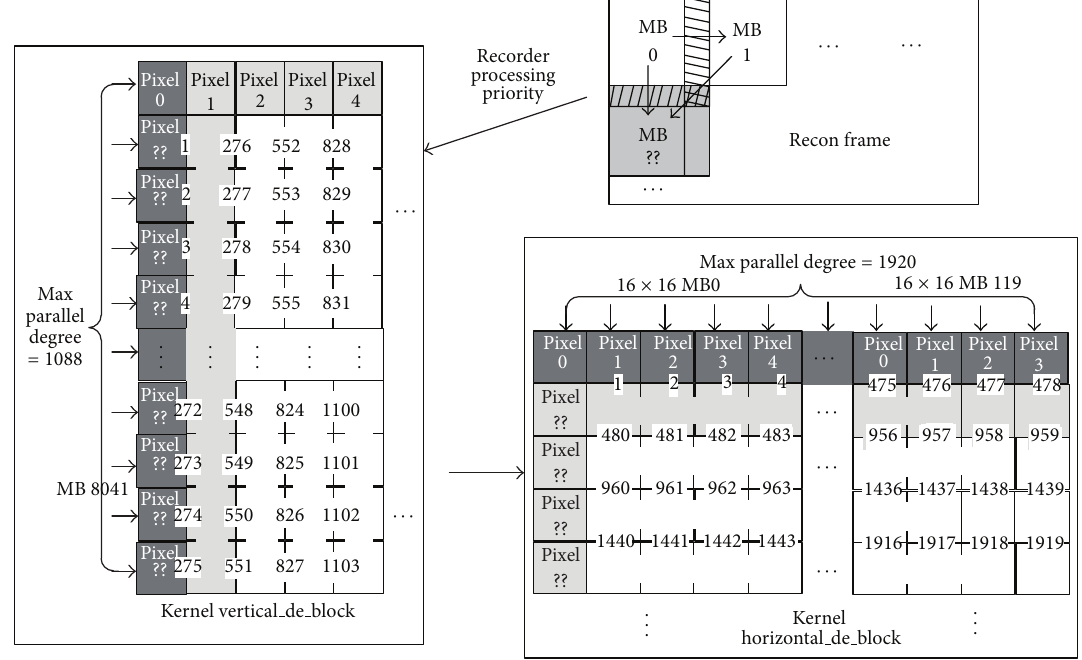
Figure 13: Direction-priority approach on GPU.